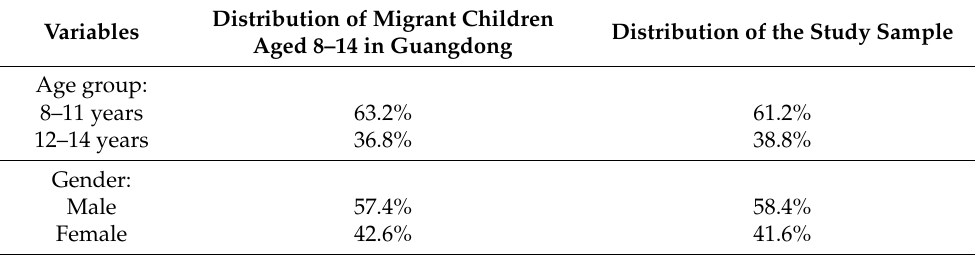
Table 1. Distributions of the target population and the study